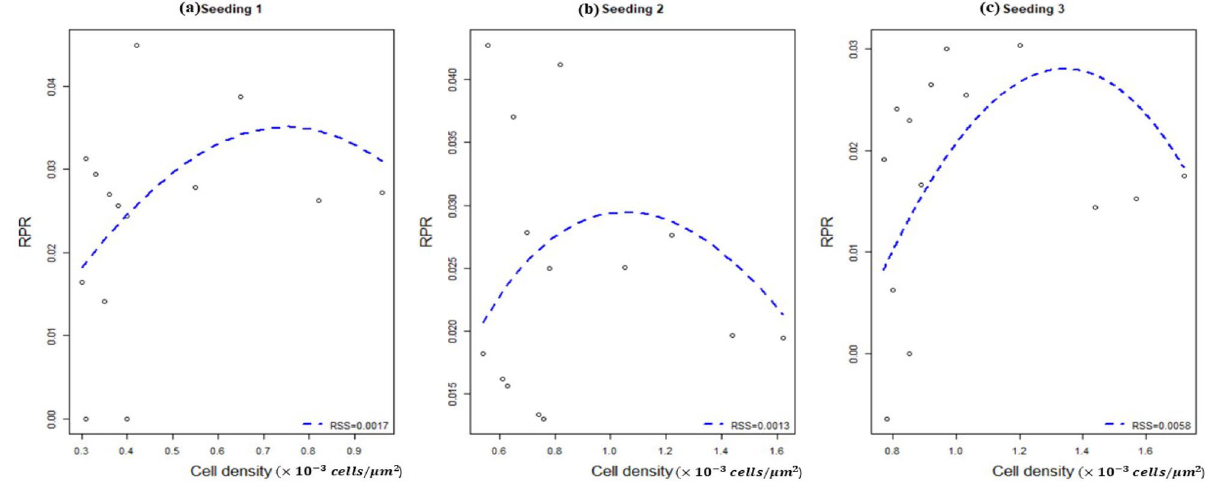
Figure 2. Our proposed model best fitted the cell density-RPR datasets for all of the seeding conditions generated through the grid-search method.